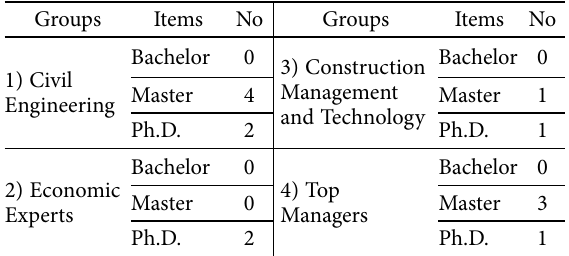
Table 5. Important indexes for evaluation of different longitudinal ventilation methods used in tunnels Table 6. Background information of experts